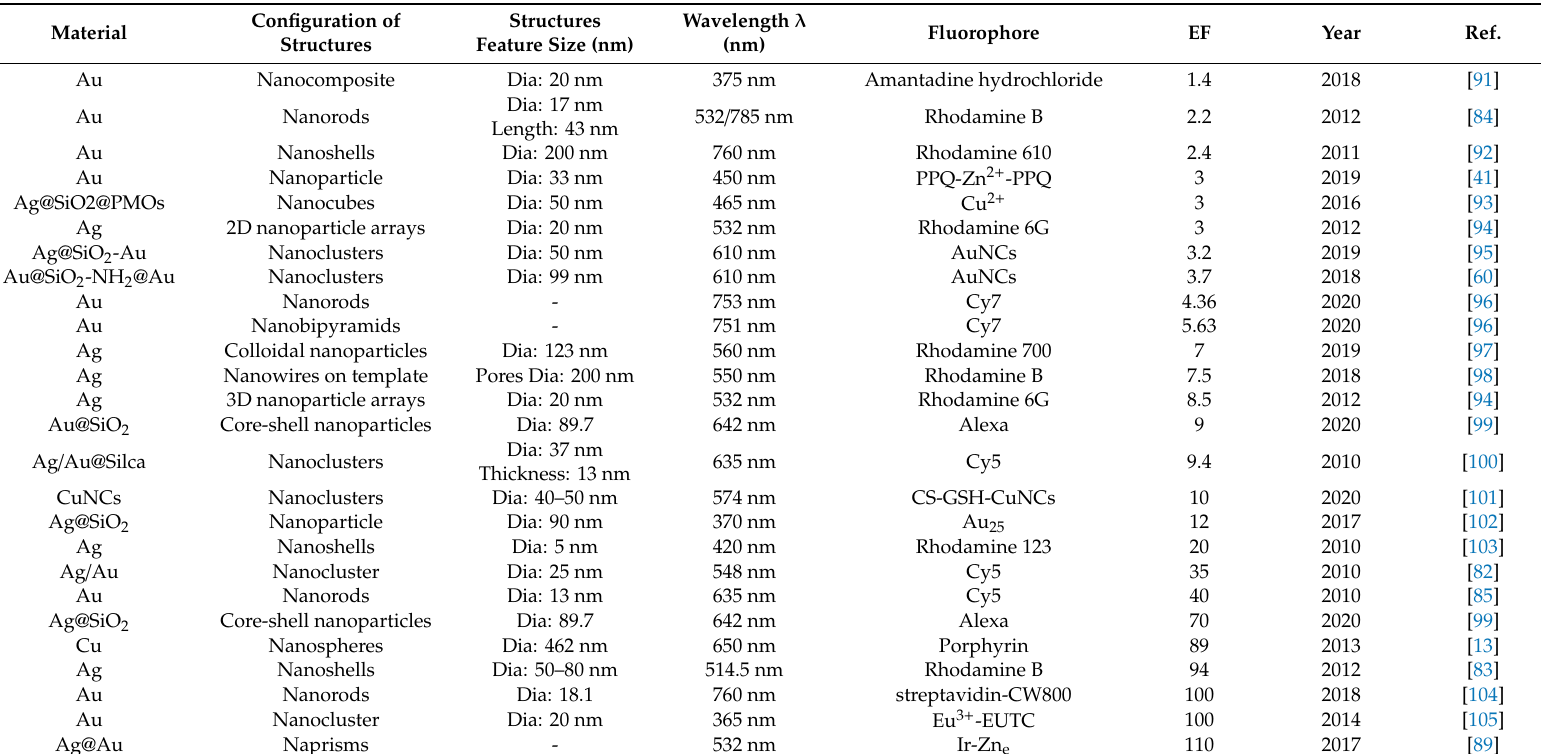
Table 2. Summary of various nanostructures and nanoparticles fabricated via chemical synthesis methods with di ff erent shapes and geometries, and their experimentally determined enhancement factor (EF), with feature size, excitation wavelengths, used fluorophores, and publication information such as year and reference, for further